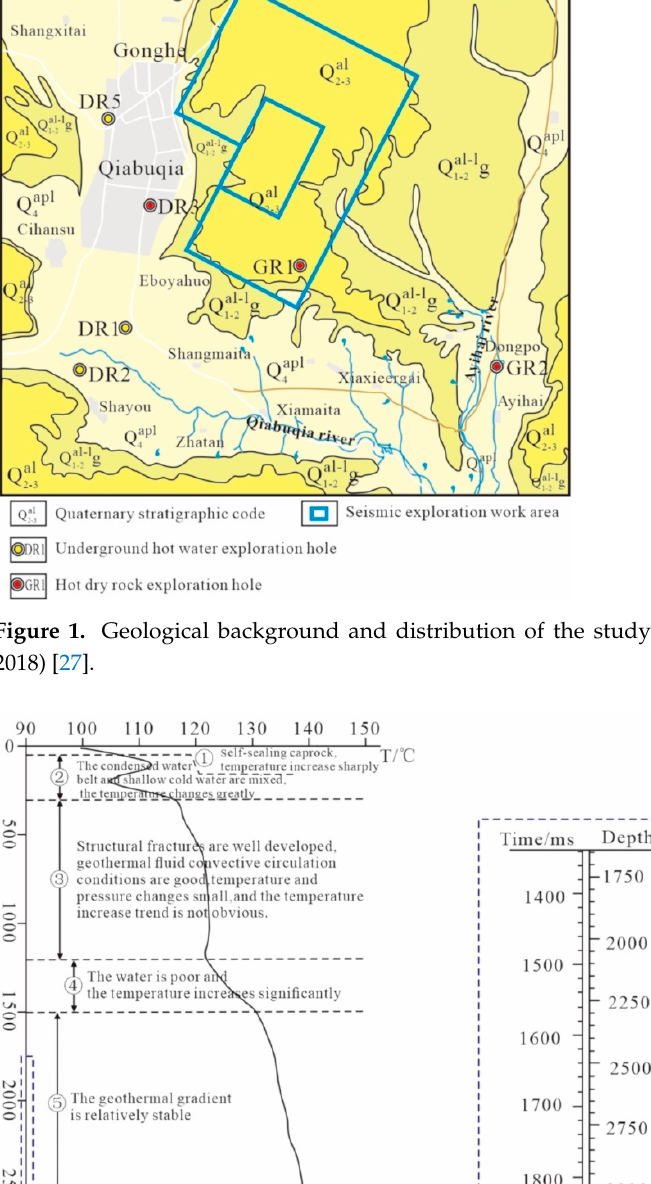
Figure 2. Schematic diagram of granite top surface. ( a ) The comprehensive diagram of logging data. ( b ) Time depth conversion relationship. The buried depth of the top layer of Gonghe granite is 2100–2300 m underground, while the hot dry rock with a high heat and high utilization value is distributed below 3050 m underground. After the time–depth conversion of the seismic data, it can be seen that the area where the hot dry rock is located is about 1.8 s below the seismic data.